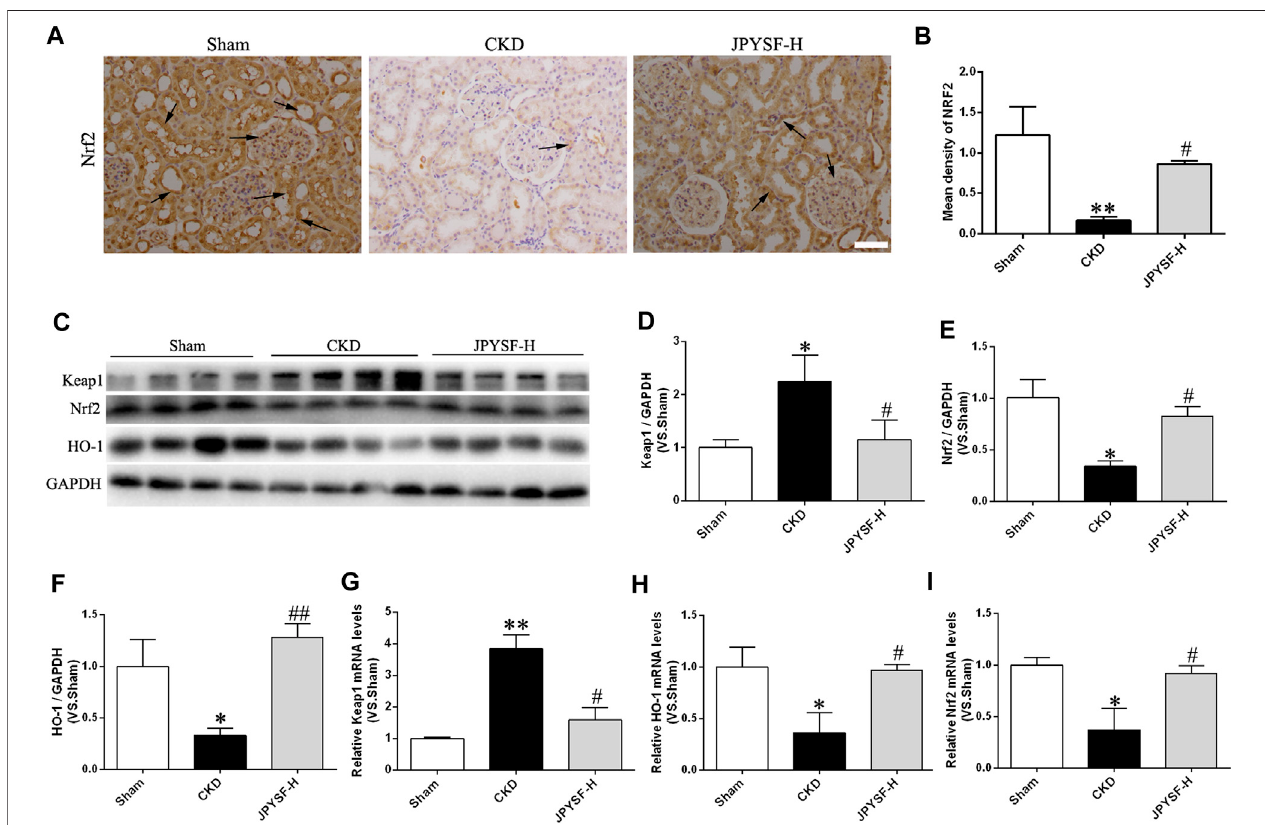
FIGURE 6 | JPYS formula activates the Nrf2 signaling in the kidneys from CKD rats. (A) IHC staining of Nrf2 in the kidney ( × 200, scale bar (cid:2) 100 μ m). (B) Quanti fi cation ofNrf2 density. Nrf2-positive areas are indicated by arrows. (C) Representative western blots for Keap1, Nrf2, HO-1, and GAPDH protein expression in kidney tissue. (D) Quantitative analysis of Keap1/GAPDH. (E) Quantitative analysis of Nrf2/GAPDH. (F) Quantitative analysis of HO-1/GAPDH. Relative mRNA expression levelsofKeap1 (G) ,HO-1 (H) ,andNrf2 (I) .Alldataareexpressed asmeans ± SEM.* p < 0.05,** p < 0.01vs.theshamgroup;# p < 0.05,## p < 0.05vs. CKD